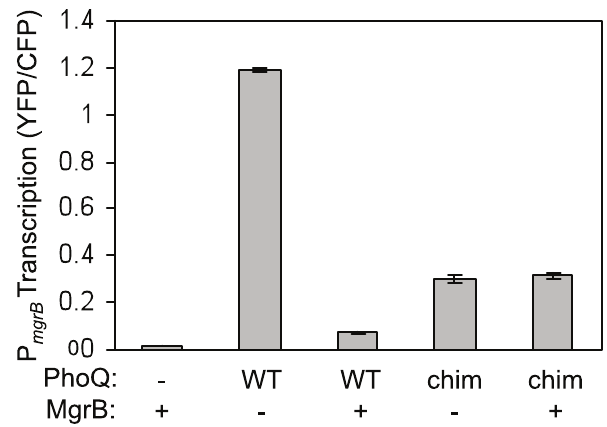
Figure 4. Alteration of the PhoQ periplasmic domain blocks the repressive effect of MgrB. Fluorescence of an mgrB transcriptional reporter, AML21 ( mgrB 2 phoQ 2 ), which was transformed with a control plasmid (pEB52) or a plasmid containing mgrB (pAL8) and with a compatible plasmid expressing wild-type PhoQ (pLPQ2), a chimera in which the periplasmic domain of E coli PhoQ was replaced with the corresponding domain from P. aeruginosa PhoQ (pLPQ*2), or a control plasmid (pGB2). Fluorescence was measured from cells grown at 30 u C in minimal glucose medium with 100 m M MgSO 4 as described in Materials and Methods. Cells were grown at 30 u C for consistency with bacterial two-hybrid experiments—Figure 5 and Figure S3. Similar results were observed for cells grown at 37 u C (data not shown). The error bars represent the range of means of two independent cultures. (WT: wild- type, chim: chimera).